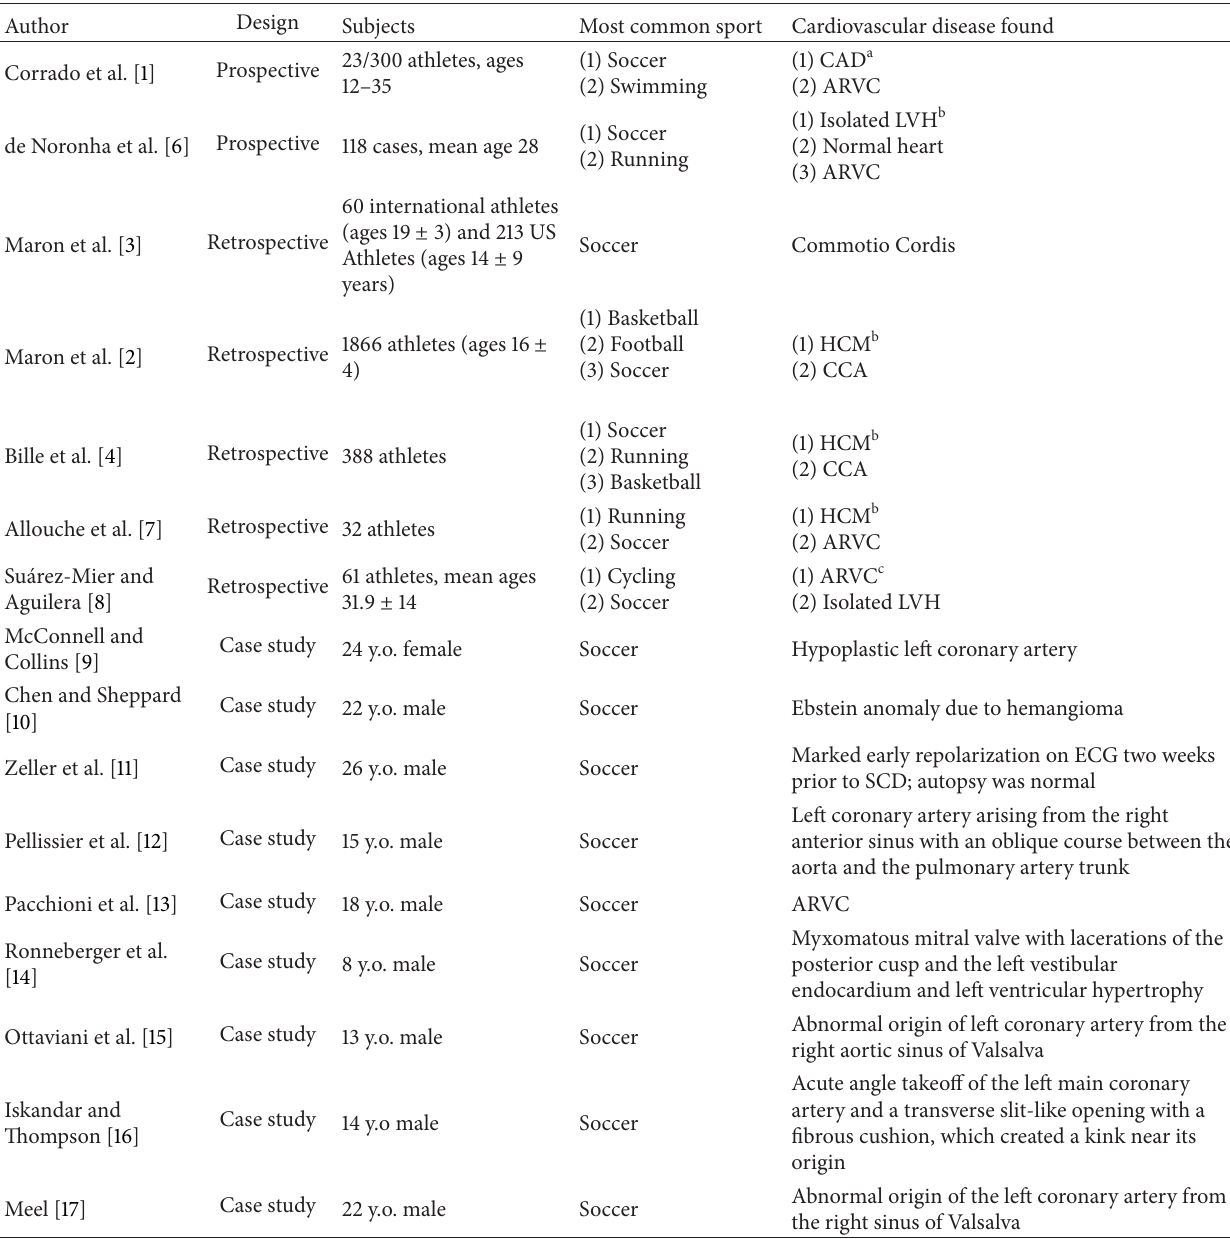
Table 1: Studies reporting SCD in